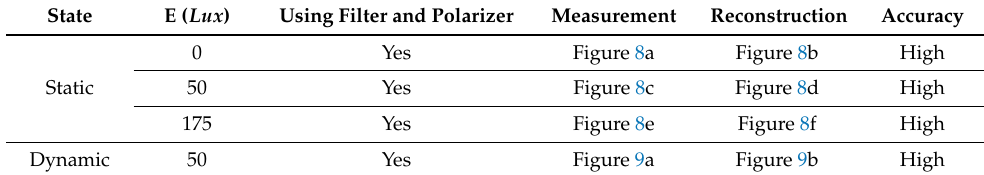
Table 2. Summary of measurement and reconstruction at spatial frequency being 1.0 lp